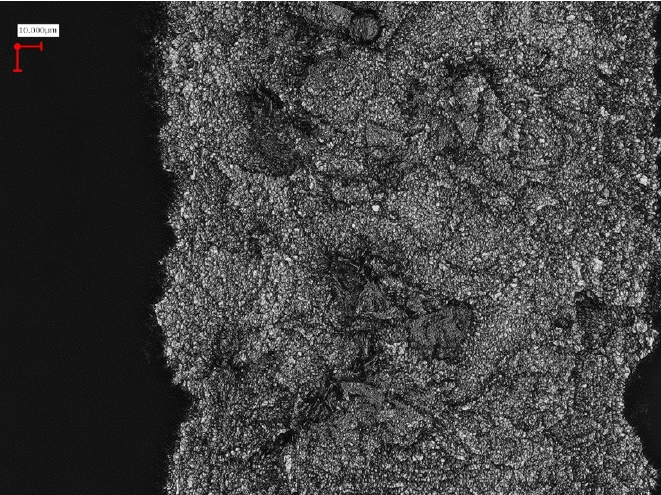
Figure 4. Sandblasted, large grit, acid-etched implant surface (SLA) demonstrating areas of particle detachment, and topographic changes after insertion (darker areas).